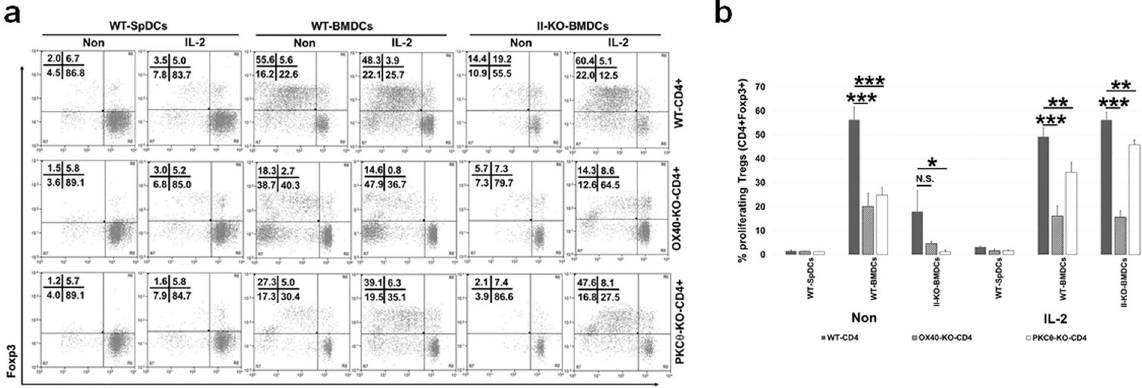
Figure 5. Exogenous IL-2 rescues the Treg proliferation phenotype when added to co-cultures containing WT and PKC θ -KO not OX40-KO CD4 + T-cells. Total WT, OX40-KO and PKC θ -KO splenic CD4 + T-cells, isolated and CellTrace-labelled, were co-cultured with either WT-BMDCs or II-KO-BMDCs in the presence or absence of exogenous IL-2. After 5 days, cells were harvested and analysed by FACS. ( a ) Representative dot plots show the proliferating Tregs upon co-culture of CD4 + T-cells. ( b ) Bar graphs comparing the percentage of proliferating Tregs from OX40-KO and PKC θ -KO to WT CD4 + T-cells, in various co-culturing conditions. Values show average ± SD, * P < 0.05, ** p < 0.005, and *** p <